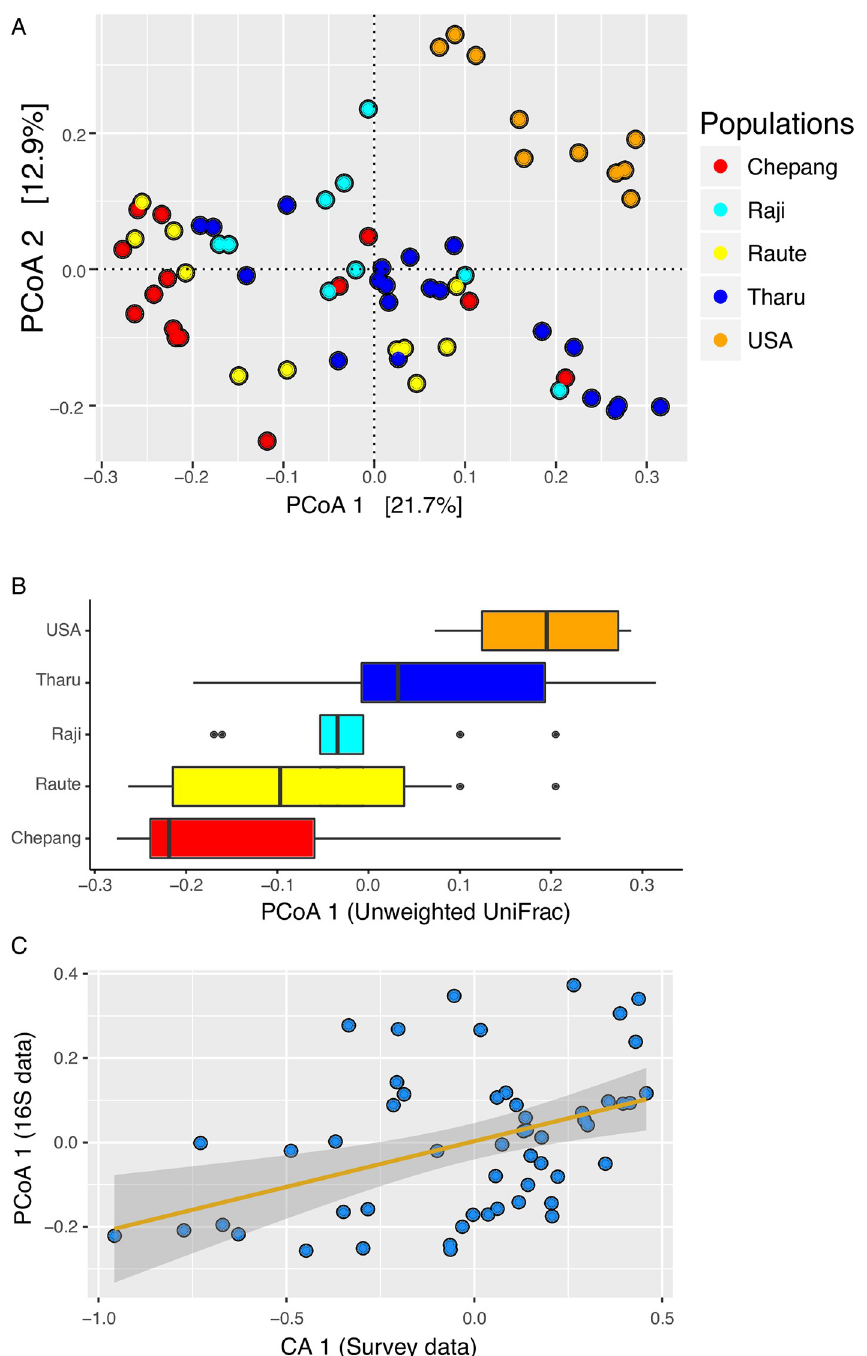
Fig 3. Gut microbiome compositions show gradients corresponding to lifestyles. (A) PCoA of the unweighted UniFrac distances of the 16S rRNA data colored by populations. Each dot represents an individual, and colors indicate the populations. Chepang foragers (red), Raute (yellow), and Raji (cyan) communities that are transitioning from foraging to farming; Tharu farmers (blue); and Americans (orange). (B) Distributions of populations along the PCoA1 axis show patterns of separation by lifestyles. (C) Gut microbial composition of the Himalayan populations represented by the primary dimension of the unweighted UniFrac distance (PCoA1) strongly correlates with lifestyle differences represented by the top dimension of the corresponding analysis performed on the survey data (CA1, Spearman’s Rho = 0.44 and P value = 0.001). Correlation between CA2 and PCoA1 was not statistically significant. The data underlying this figure can be found in S1 Data. CA, correspondence analysis; PCoA, Principal Coordinates Analysis; rRNA, ribosomal